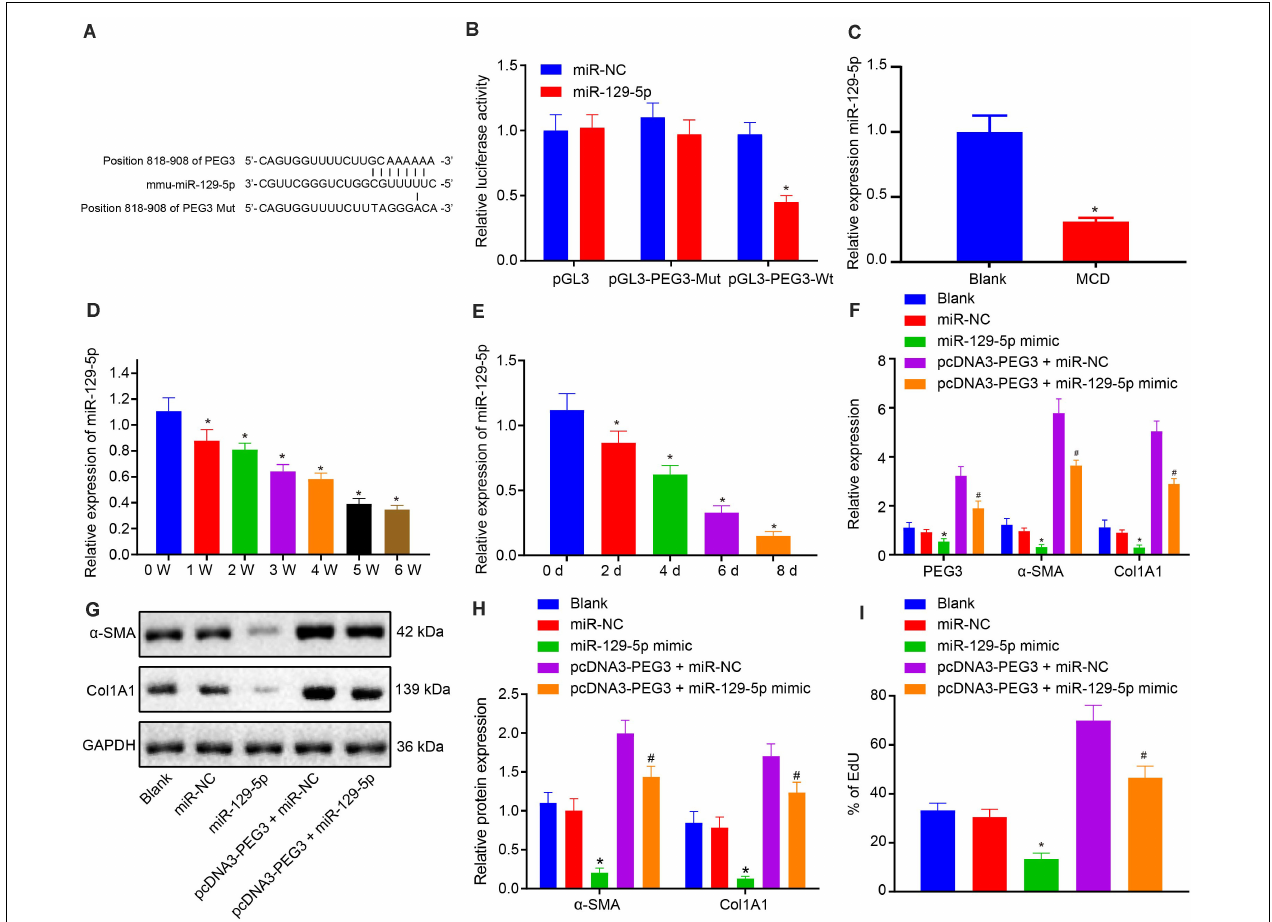
FIGURE 5 | miR-129-5p negatively regulates the expression of PEG3 in HSCs. (A) Binding sequences between PEG3 and miR-129-5p. (B) Relative luciferase activity of pGL3-PEG3-WT and pGL3-PEG3-Mut. (C) Relative expression of miR-129-5p in liver tissues from mice on 5-week MCD diet ( n = 6). (D) Relative expression of miR-129-5p in HSCs of mice on MCD diet from weeks 0 to 6. (E) Relative expression of miR-129-5p in HSCs of mice on normal diet from days 0 to 8. (F) Relative mRNA expression of PEG3, α -SMA, and Col1A1 after transfection determined by RT-qPCR. (G) Protein bands of α -SMA, Col1A1, and GAPDH after transfection. (H) Relative protein expression of α -SMA and Col1A1 normalized to GAPDH after transfection determined by western blot analysis. (I) HSC proliferation of mice on normal diet detected by EdU assay. * p < 0.05 vs. the blank group (mice on normal diet). # p < 0.05 vs. the pcDNA3-PEG3 + miR-NC group (HSCs transfected with pcDNA3-PEG3 + miR-NC). All data were measurement data and expressed as mean ± standard deviation. Comparison between two groups was analyzed using unpaired t -test. One-way analysis of variance was used for data comparison among multiple groups. The experiment was independently repeated three times. N = 6. Wt, wild-type; Mut, mutant; EdU, 5-ethynyl-2 (cid:48) -deoxyuridine; NC, negative